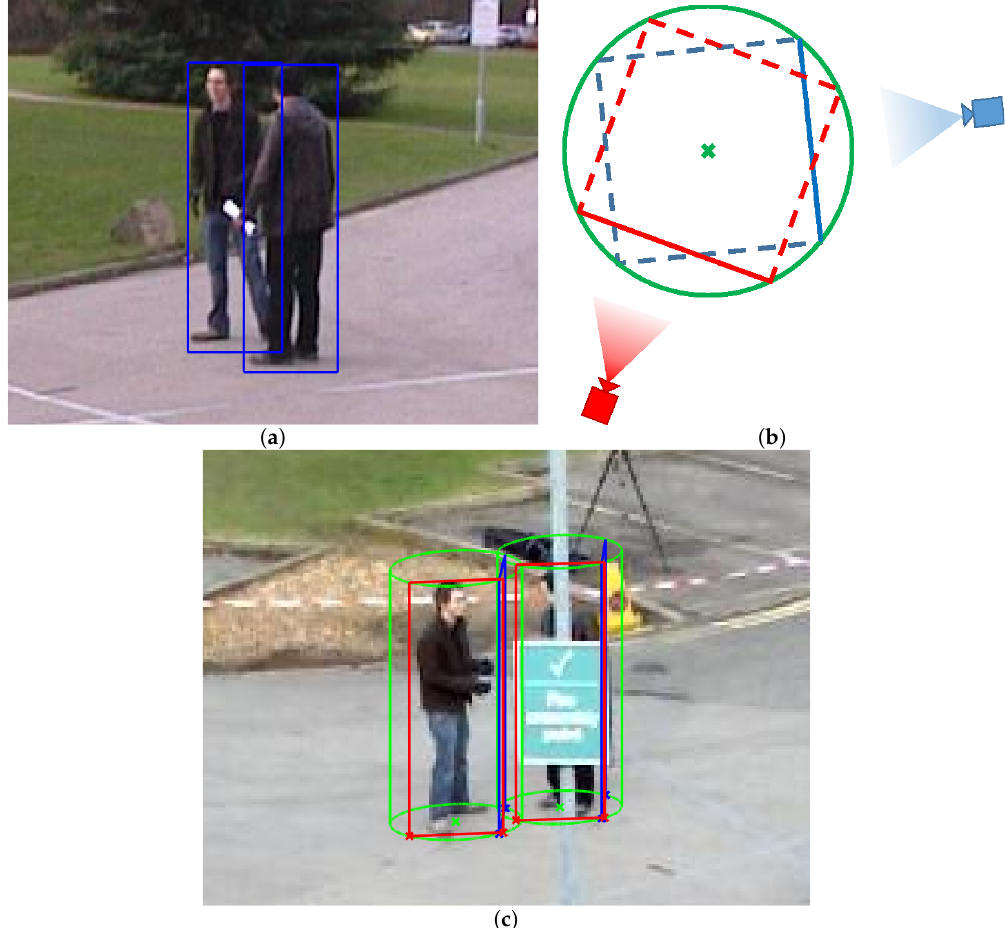
Figure 2. Overview of the proposed technique: ( a ) shows two detection bounding box examples; ( b ) schematizes the geometric process; and ( c ) contains a representation of the resulting cylinders (green), the original bounding box (blue, very tilted due to the angle between the cameras’ viewpoints), and the resulting bounding boxes (red). (a,c) are cropped versions for visualization